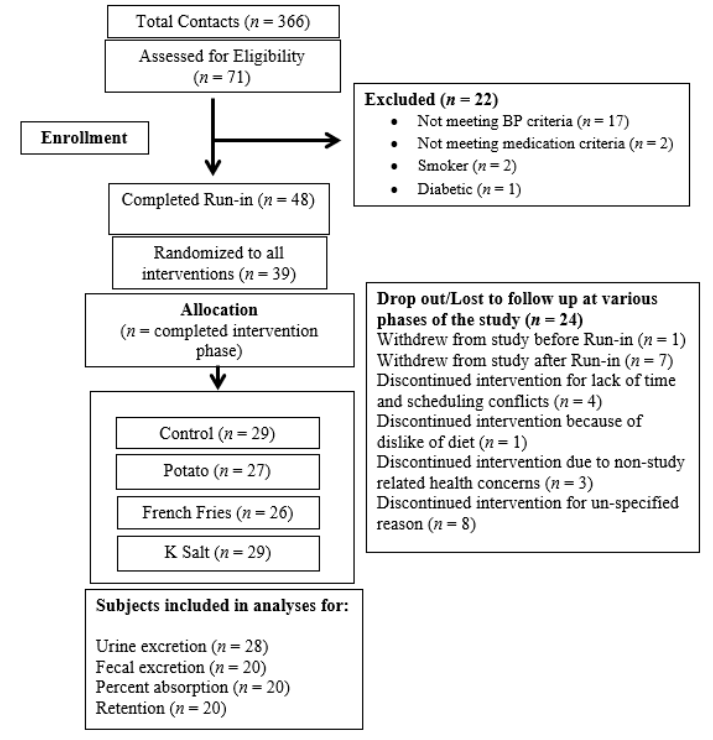
Figure 1. Flow Diagram of Study.